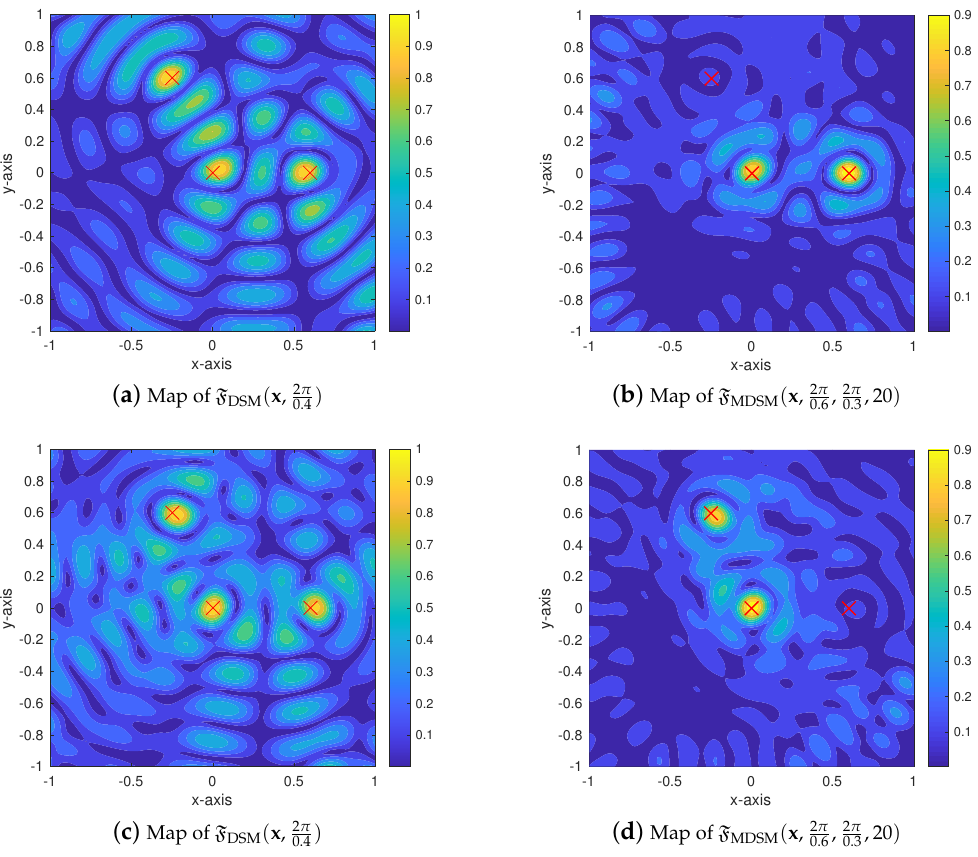
Figure 9. (Example 7) Simulation results with d = ( 0,1 ) (top line) and d = ( 1,0 ) (bottom line). The red-colored marks × denote the location of